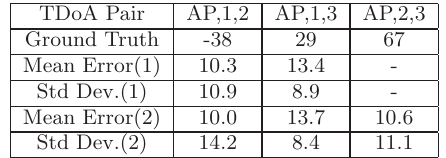
Outdoor TDoA comparison results in